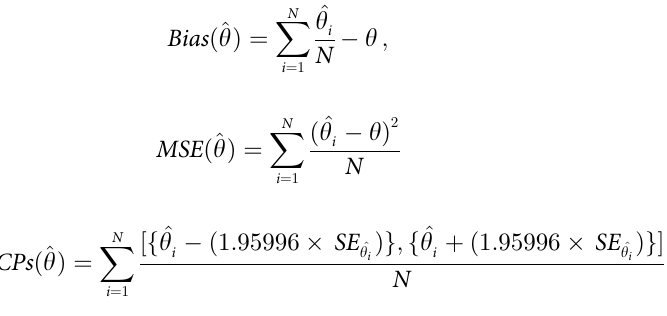
out for N = 2000 times, each with given n and computed the average estimates (AEs) as well as their average biases (Bias), mean squared errors (MSEs) and coverage probabilities (CPs) of the MLEs. X N Bias ð ^ y Þ ¼